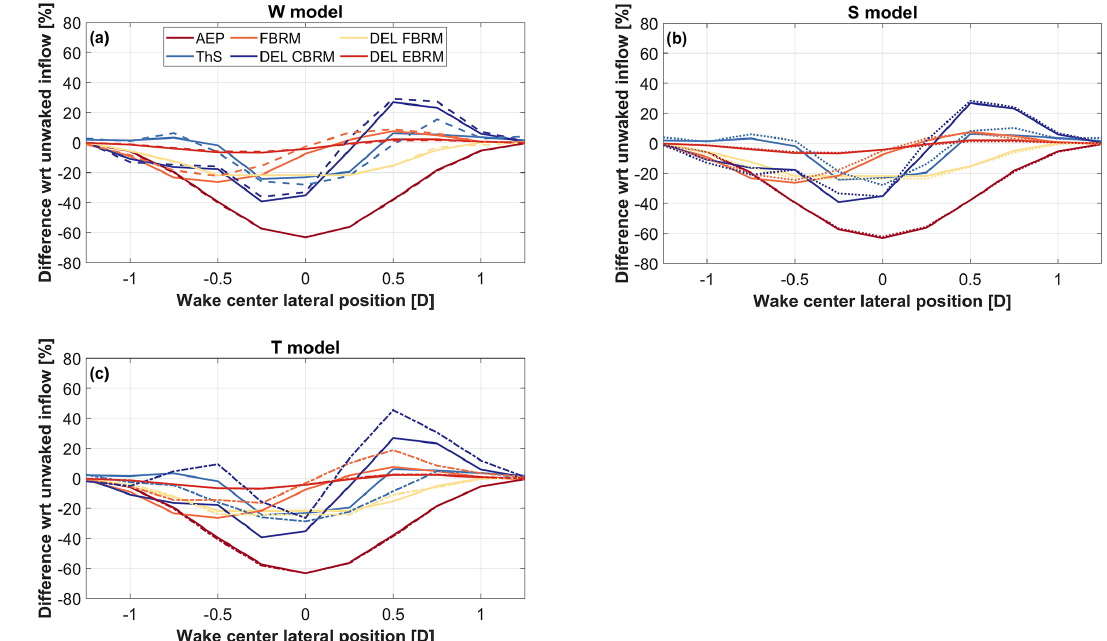
Figure 8. Comparison of key indicators between unwaked and waked inflows for different lateral distances from the wake center. The solid line corresponds to the full-scale model. (a) W model (dashed line), (b) S model (dotted line), and (c) T model (dash-dotted line).